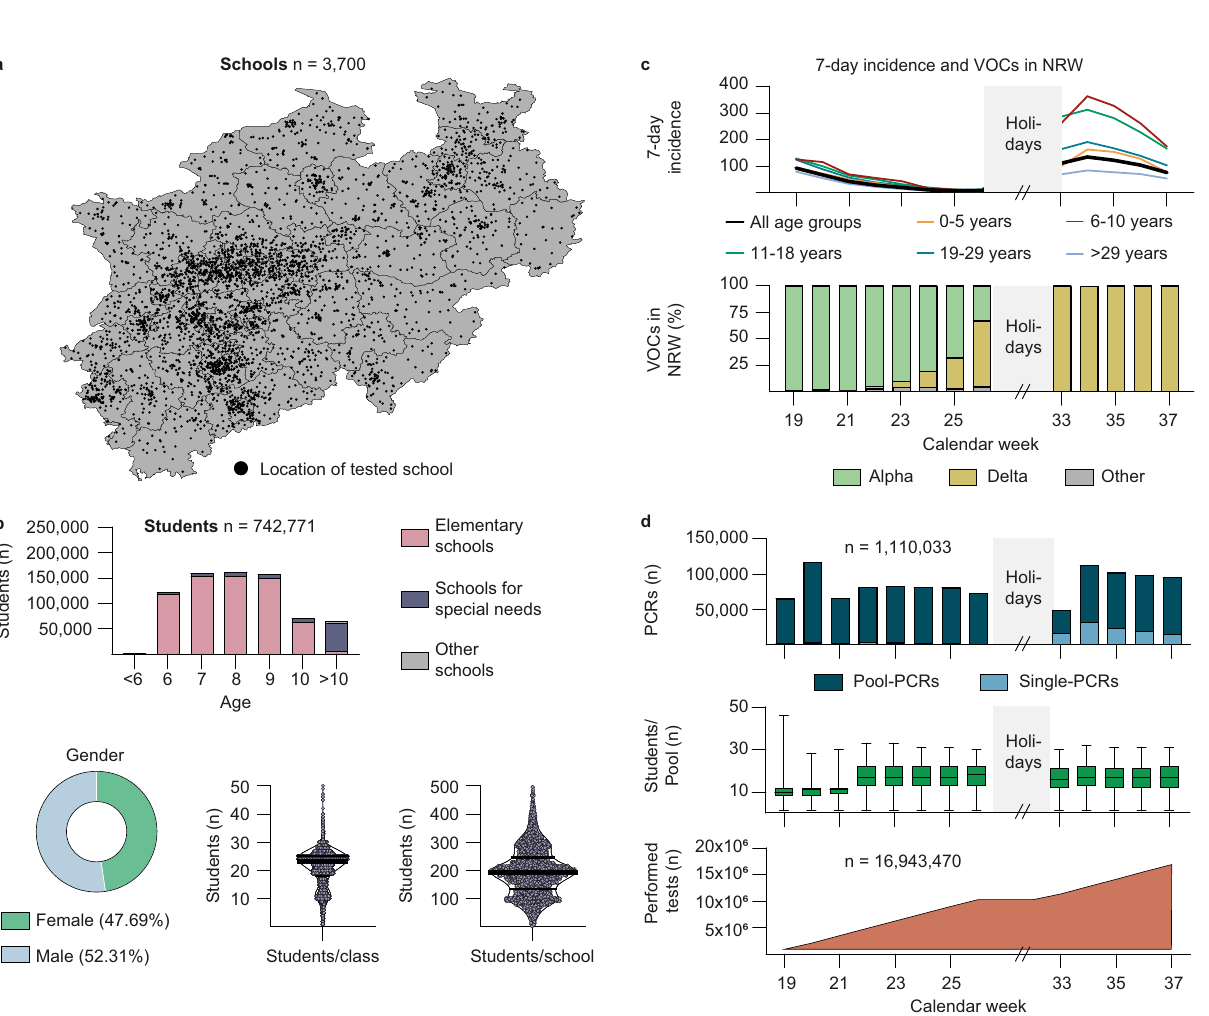
Fig. 2 Implementing the Lolli-Method screening concept in schools and daycare facilities. a Map of North Rhine – Westphalia. Black dots mark the location of each school. b Epidemiological characteristics of the tested students and characteristics of schools. Black horizontal lines in the violin plots represent median ( M ), fi rst ( Q 1) and third ( Q 3) quartile (Students/class: M = 23, Q 1 = 18, Q 3 = 25; Students/schools: M = 193, Q 1 = 134, Q 3 = 246. c 7-day incidence of different age groups (top) and frequency of variants of concern according to data published by the Robert Koch Institute (bottom) strati fi ed by calendar week. Summer holidays are marked in gray. d Number of performed RT-qPCRs (blue), average pool sizes (green) and total number of performed tests are strati fi ed by calendar week. The horizontal lines in the green Box-Whisker-Plot indicate the medians, the lines at the top and at the bottom of the boxes indicate fi rst and third quartiles and the error bars represent minimum and maximum pool 19 – 21 and 22 – 26/33 – 37, respectively, estimating an overall SARS- Lolli-Method was applied to 698 daycare facilities in the city of CoV-2 testing of 16,943,470 swabs within a time period of 13 weeks Cologne, testing approximately 48,149 children within the age of 1 – 6 (Fig. 2d). Mean turn-around time for processing of pool-RT-qPCRs years and 13,577 staff members twice per week for a period of was 7.59 h and 9.14 h for single-RT-qPCRs (Supplementary Fig. 4). 6 months (Supplementary Fig. 4). Both in schools and daycare 96.2% of all pool-RT-qPCR results were communicated before facilities, the program was well accepted and continued beyond the 6:00 a.m. on the next day (Supplementary Data 6). In addition, the reported time period.